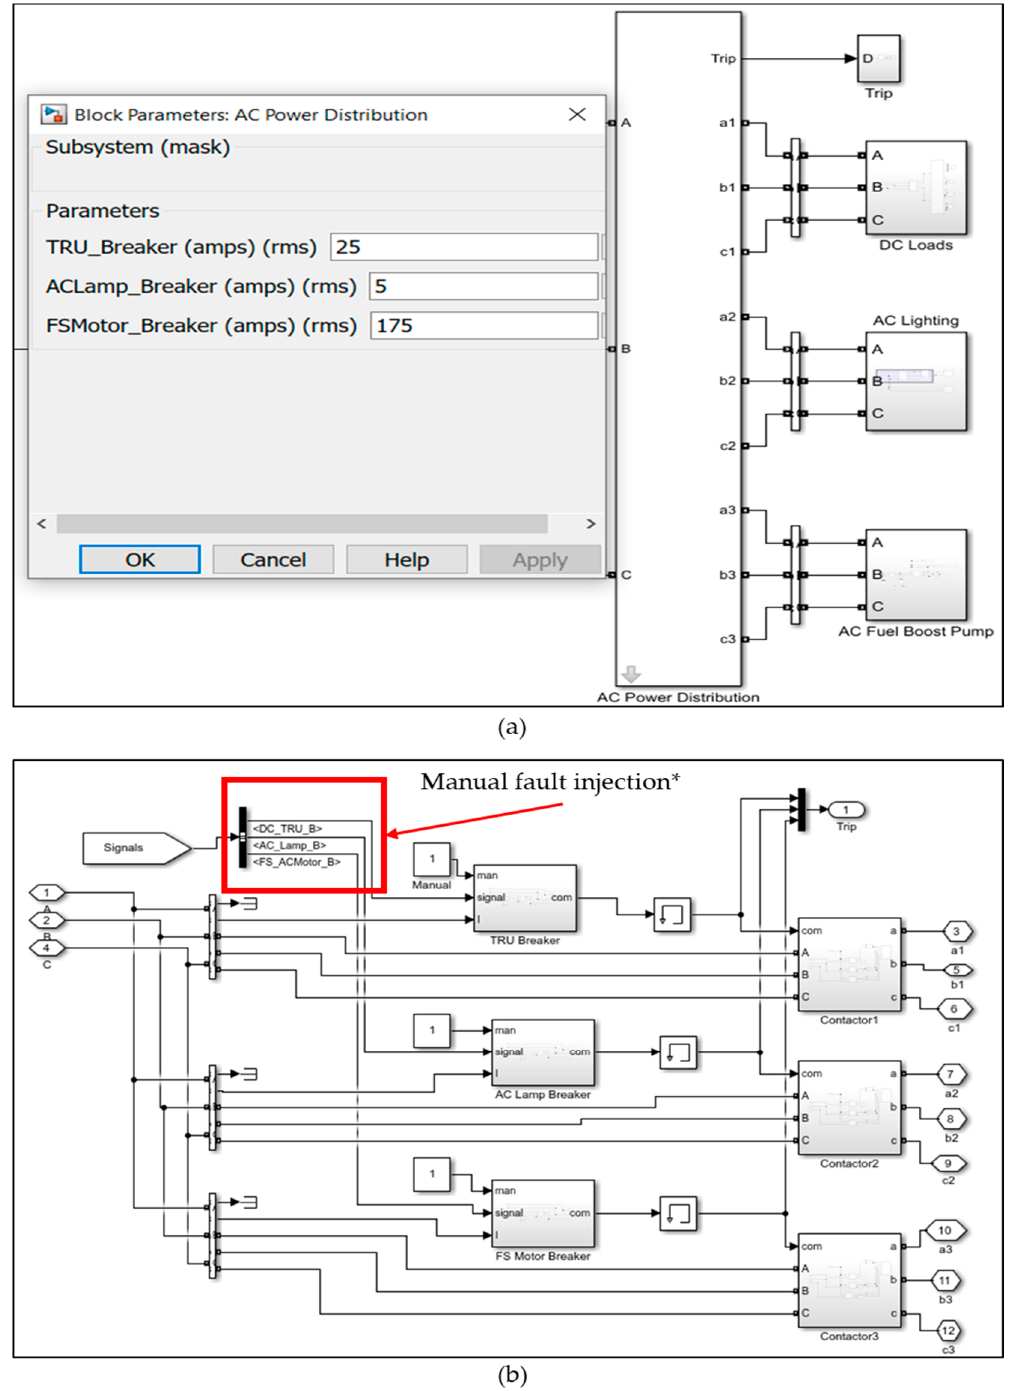
Figure 2. Fault injection in circuit breakers connecting generators to other aircraft systems: ( a ) User input current limits set for circuit breakers; ( b ) Manual tripping input inside the AC power distribution mask.